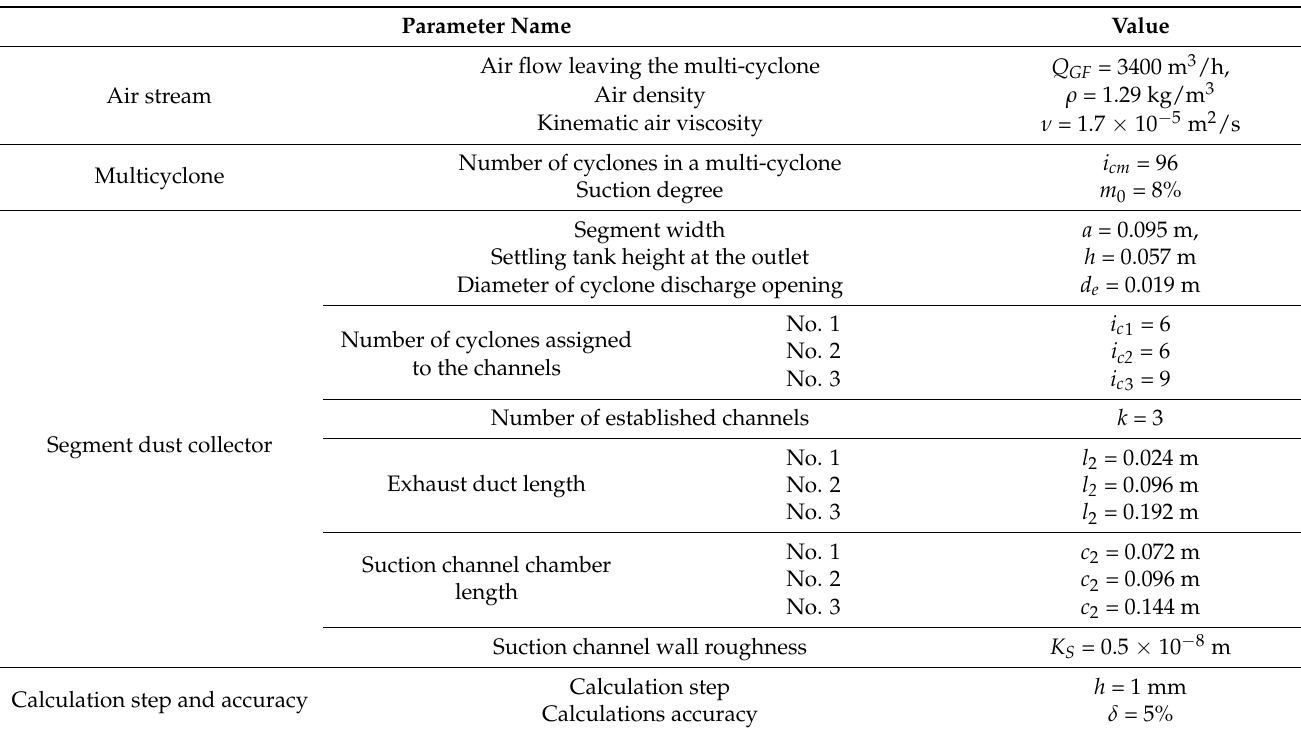
Table 1. Data for numerical calculations for the segment of the MT multi-cyclone dust settler.